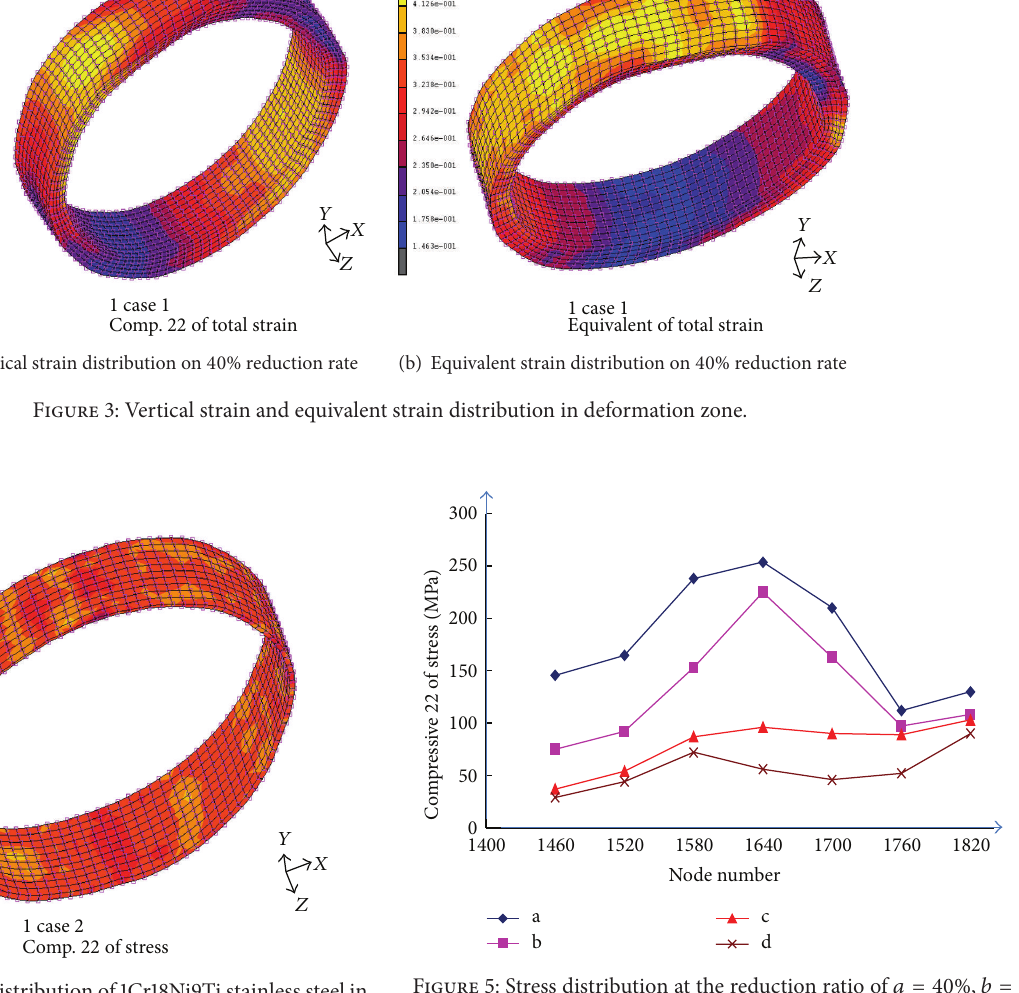
Figure 4: Vertical stress distribution of 1Cr18Ni9Ti stainless steel in rolling process.